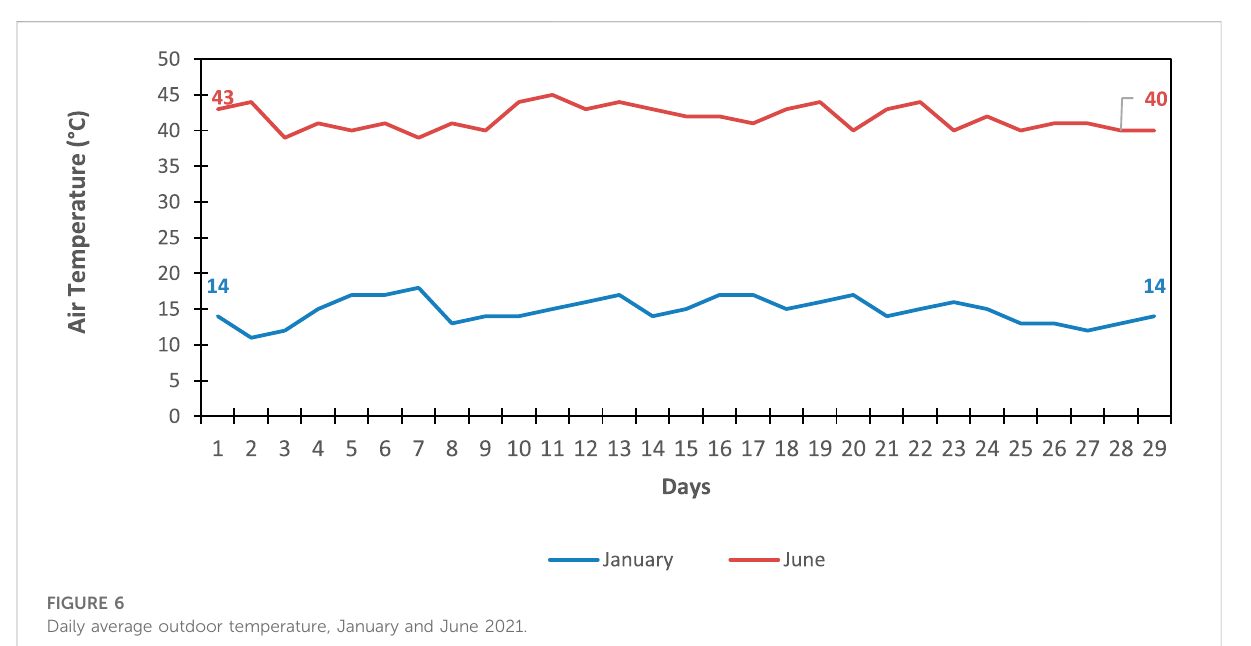
FIGURE 6 Daily average outdoor temperature, January and June